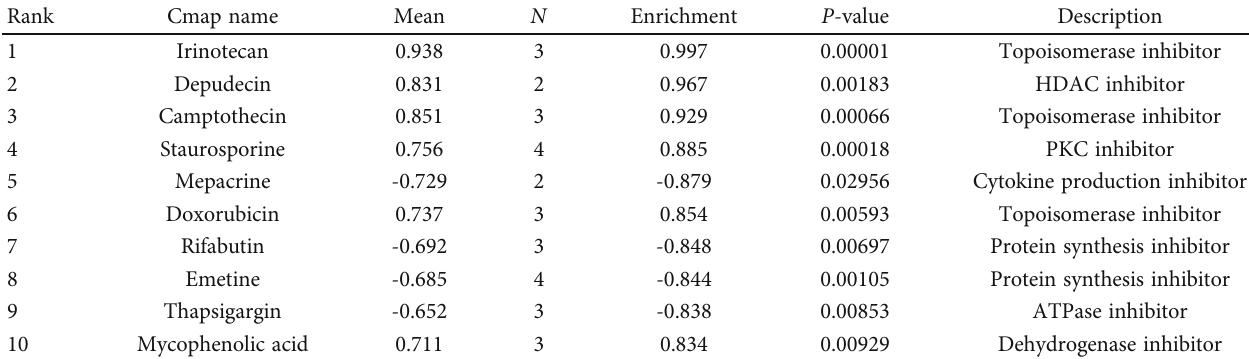
Table 1: Results of CMap